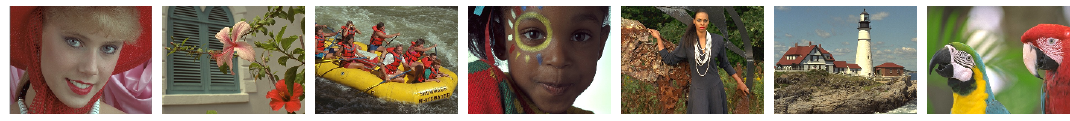
Figure 2. Overview of the Tampere Image Database from 2013 (TID2013) images employed in the Augmented Reality (AR) scenario.